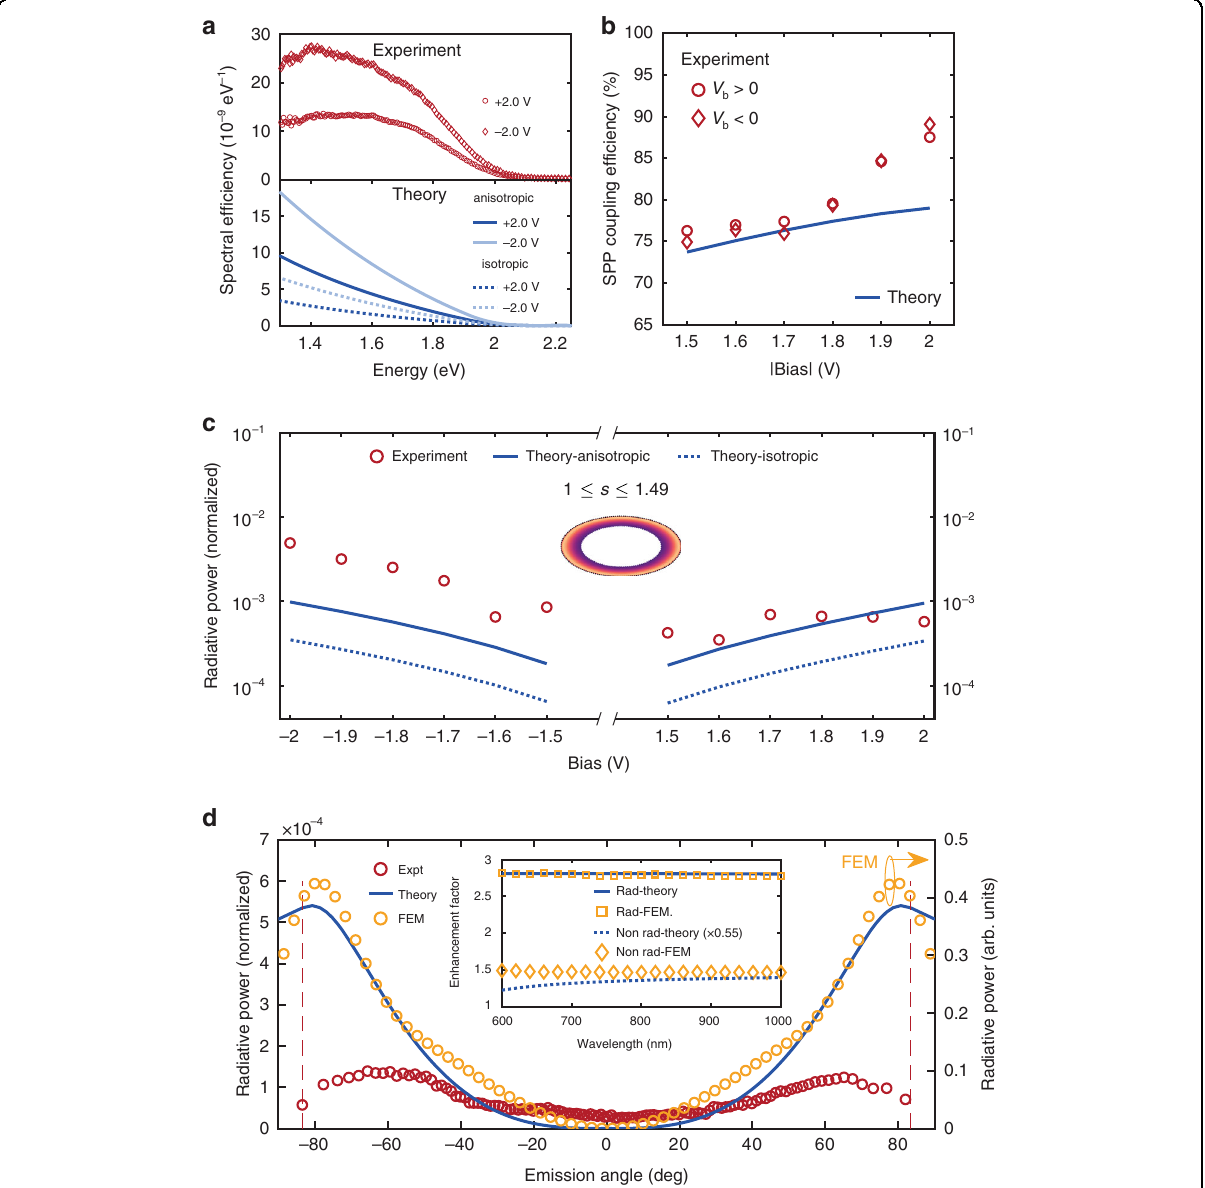
Fig. 5 Theory-experiment comparison quantifying the role of the hBN anisotropy. a Top panel: Spectral ef fi ciency (number of photons per tunneling electrons) of the junction from the experiment (top) for V b = + 2.0 V (open circle) and for – 2.0 V (open rhomb). Bottom panel: Spectral ef fi ciency calculated from theory for V b = + 2.0 V (dark blue) and for – 2.0 V (light blue). Solid and dotted lines correspond to anisotropic and isotropic cases respectively. b Relative coupling ef fi ciency for SPP excitation obtained as a function of | V b | from the experiment (for V b > 0 (open circle) and V b < 0 (open rhomb)) and from theory (solid line). c Normalized radiative power from the junction, evaluated as a function of ± V b . Inset shows the BFP angular emission range (1 ≤ s ≤ 1.49) where the radiative power is integrated (see text). d Comparison between the theory, experiment, and the FEM simulations. Normalized radiative power for V b = 2.0 V, evaluated as a function of emission angle. The left y -axis shows the results from the theory (anisotropic case, blue solid line) and the experiment (red circles), and the radiative power obtained from the FEM simulation is shown on the right y - axis (orange circles). Dashed vertical lines represent the angle corresponding to the numerical aperture of the objective. Inset shows the enhancement of the radiative (FEM (open square), theory (solid line)) and non-radiative decay rate (FEM (open rhomb), theory (dotted line)) for